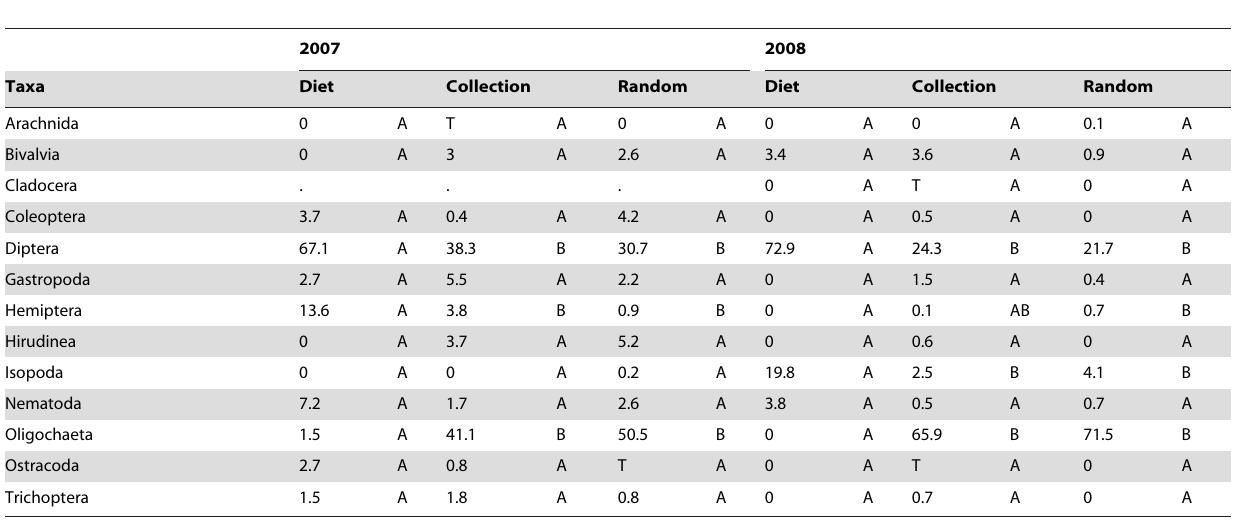
*Values with different letters within rows indicate significant differences of least-squares means (Tukey-Kramer test: P # 0.05) within that year. T indicates a trace amount of material present.